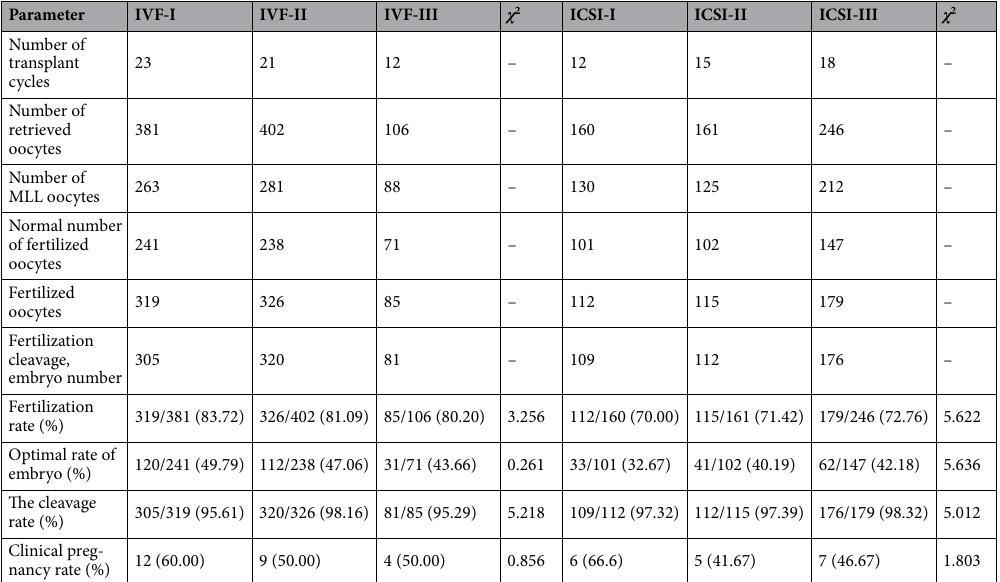
Table 4. Comparison of clinical outcomes between different subgroups. The data in the table is represented by example or example (%). According to DFI levels, IVF group was subdivided into IVF-I group (DFI ≤